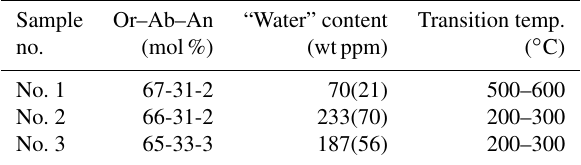
Table 1. Data of samples no. 1–3 from Liu et al. (2018).